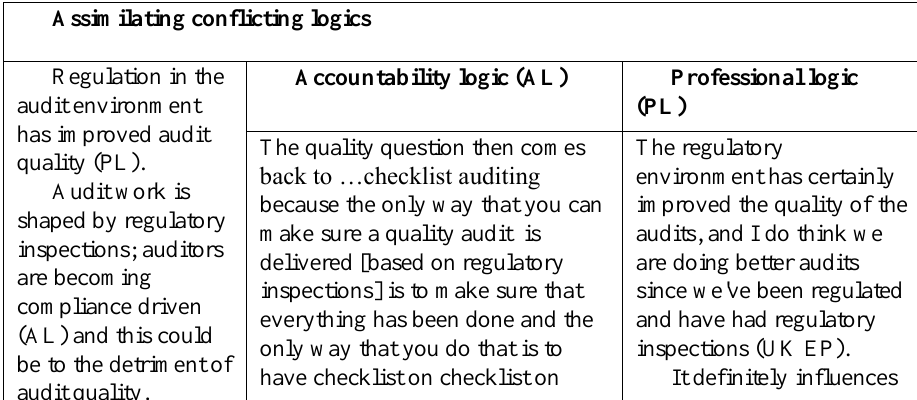
Table 5: Regulatory inspections: navigating logic multiplicity Assimilating conflicting